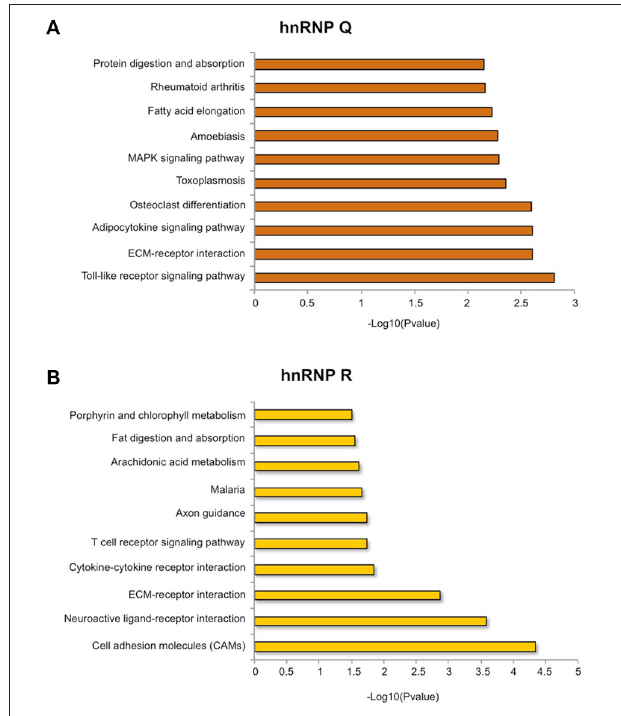
FIGURE 8 | KEGG pathway analysis of DEGs in sihnRNP Q and sihnRNP R treated cells. First ten KEGG pathway identified ( p < 0.05) in DEGs in SH-SY5Y cells depleted for hnRNP Q (A) and hnRNP R (B) . KEGG pathway analysis was performed using GOseq package.